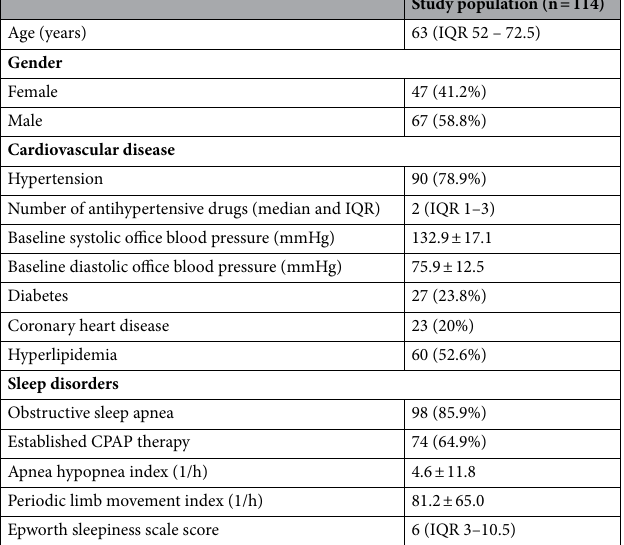
Table 1. Epidemiological and clinical baseline parameters of the study population.